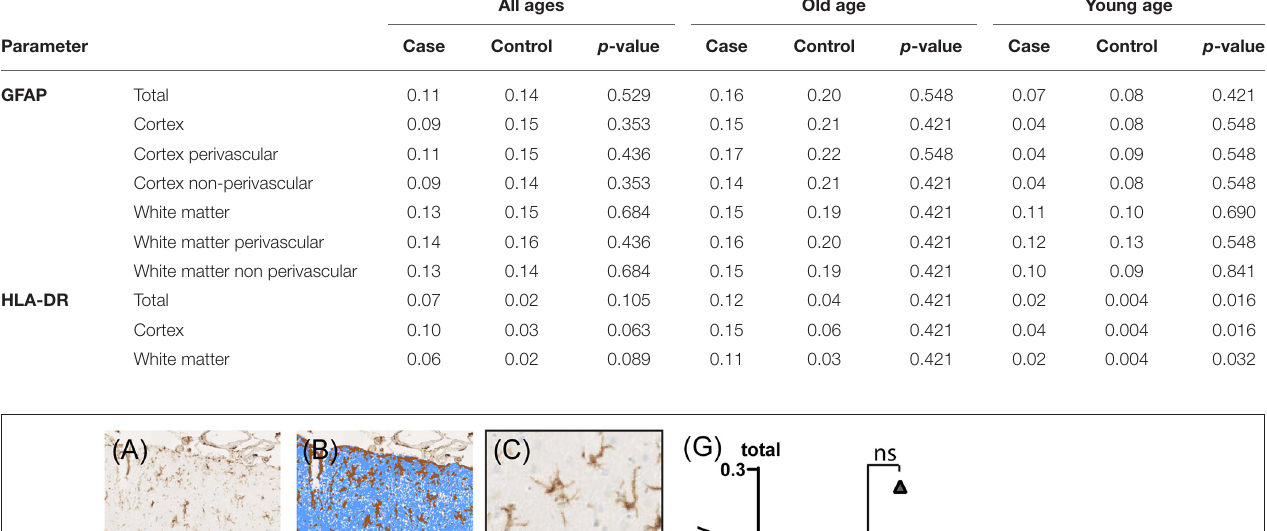
TABLE 3 | Results of quantitative image analysis of GFAP- and HLA-DR-staining of COVID-19 patients and controls (see text for details). All ages Old age